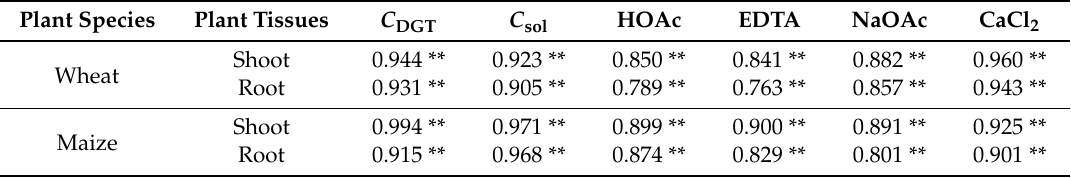
Table 2. Linear correlation coefficients ( r ) between Cd concentrations in the plant tissues and bioavailable concentrations of Cd measured by different methods in soils.